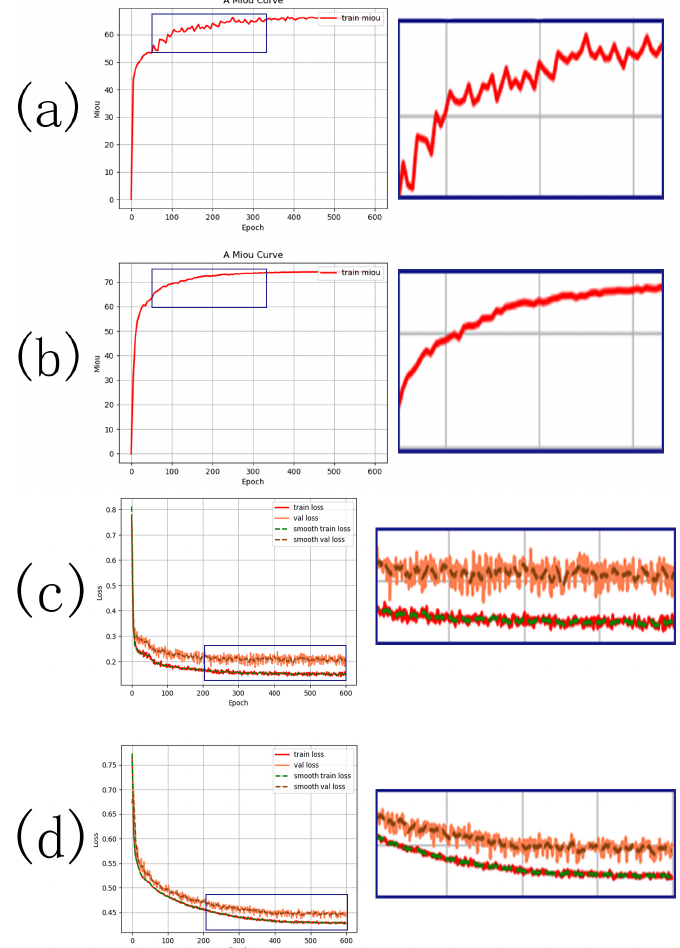
Figure 11. ( a ) Variation curve of training precision of the original model. ( b ) Variation curve of training precision of the improved model. ( c ) Variation curve of training loss of the original model. ( d ) Variation curve of training loss of the improved model.